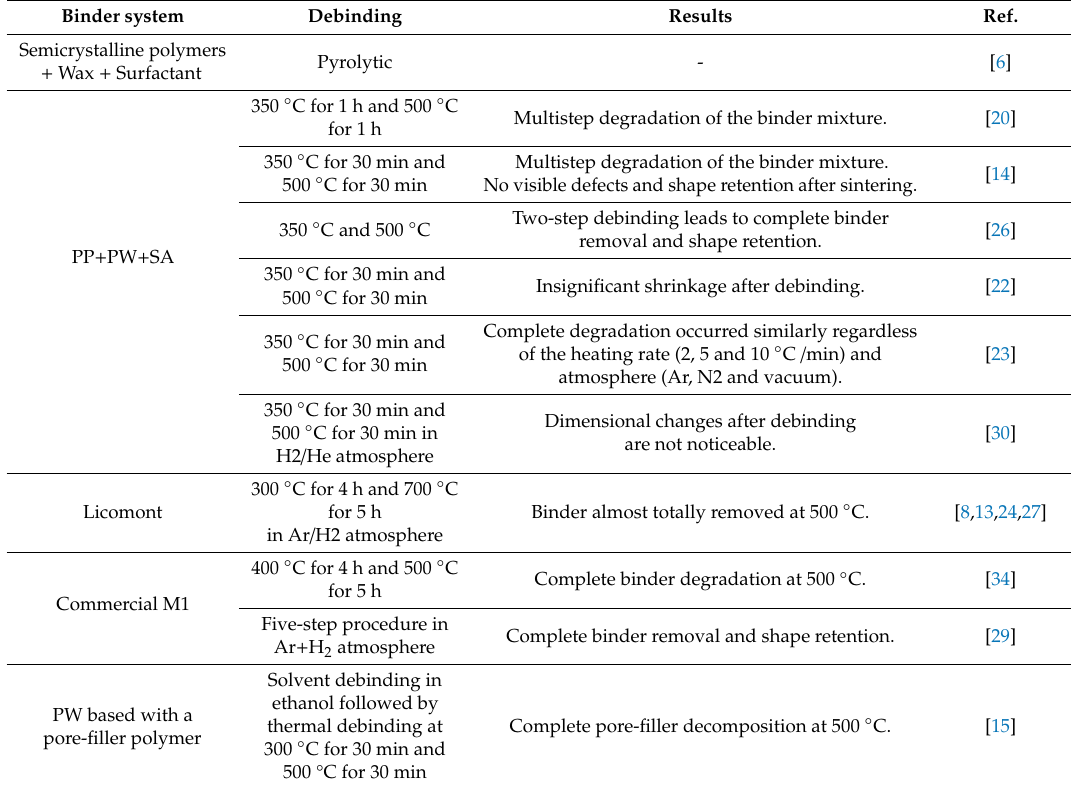
Table 5. Debinding processes applied to powder hot